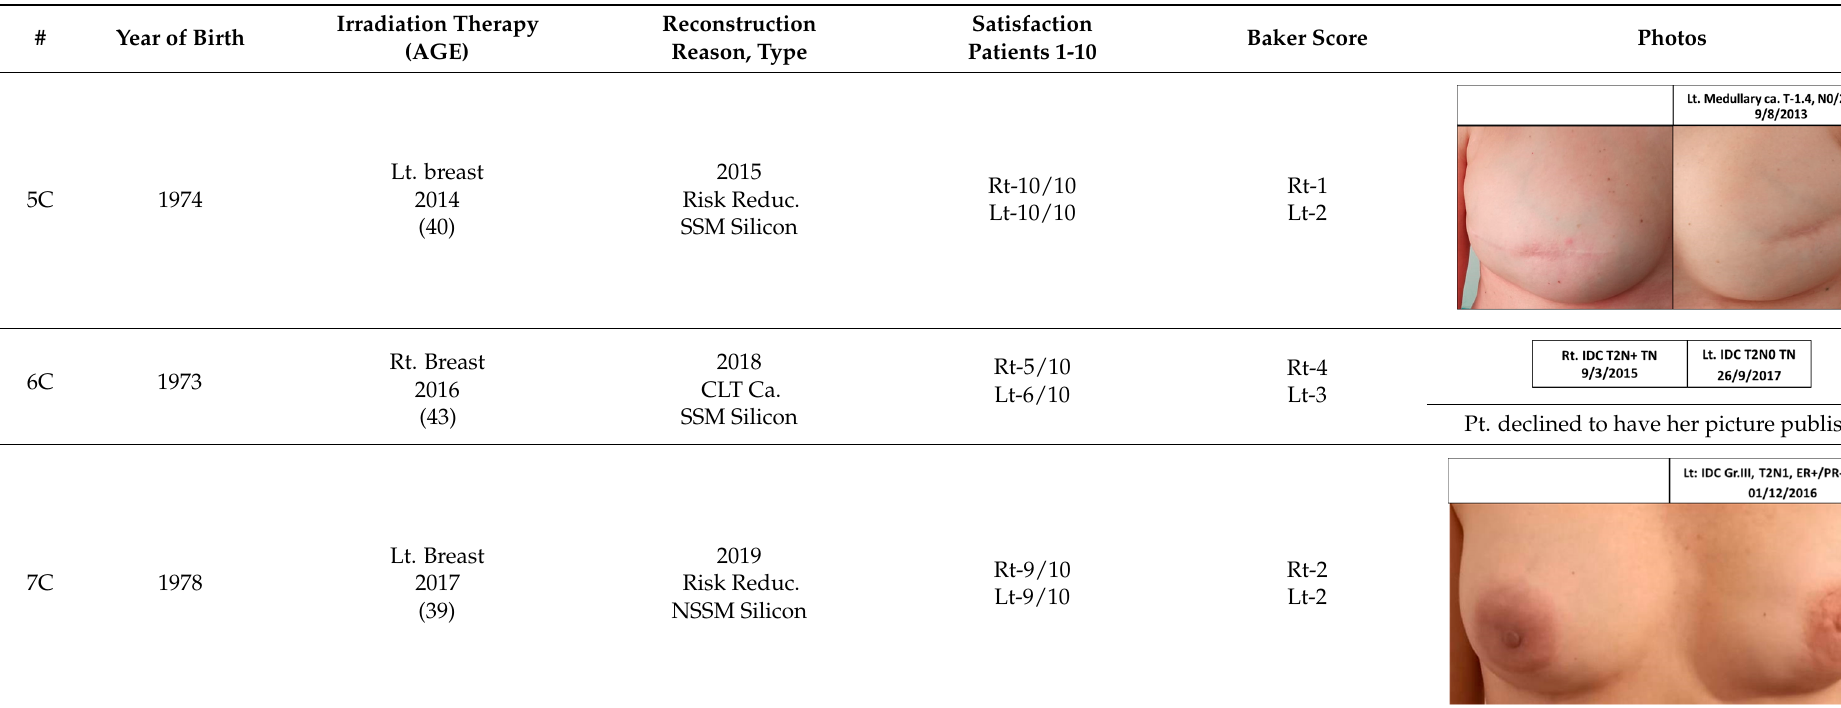
Risk Reduc.—risk reduction; CLT—contralateral; DCIS—ductal carcinoma in situ; Ca—cancer; Local Rec.—local recurrence; SSM—skin-sparing mastectomy; NSSM—nipple- and skin-sparing